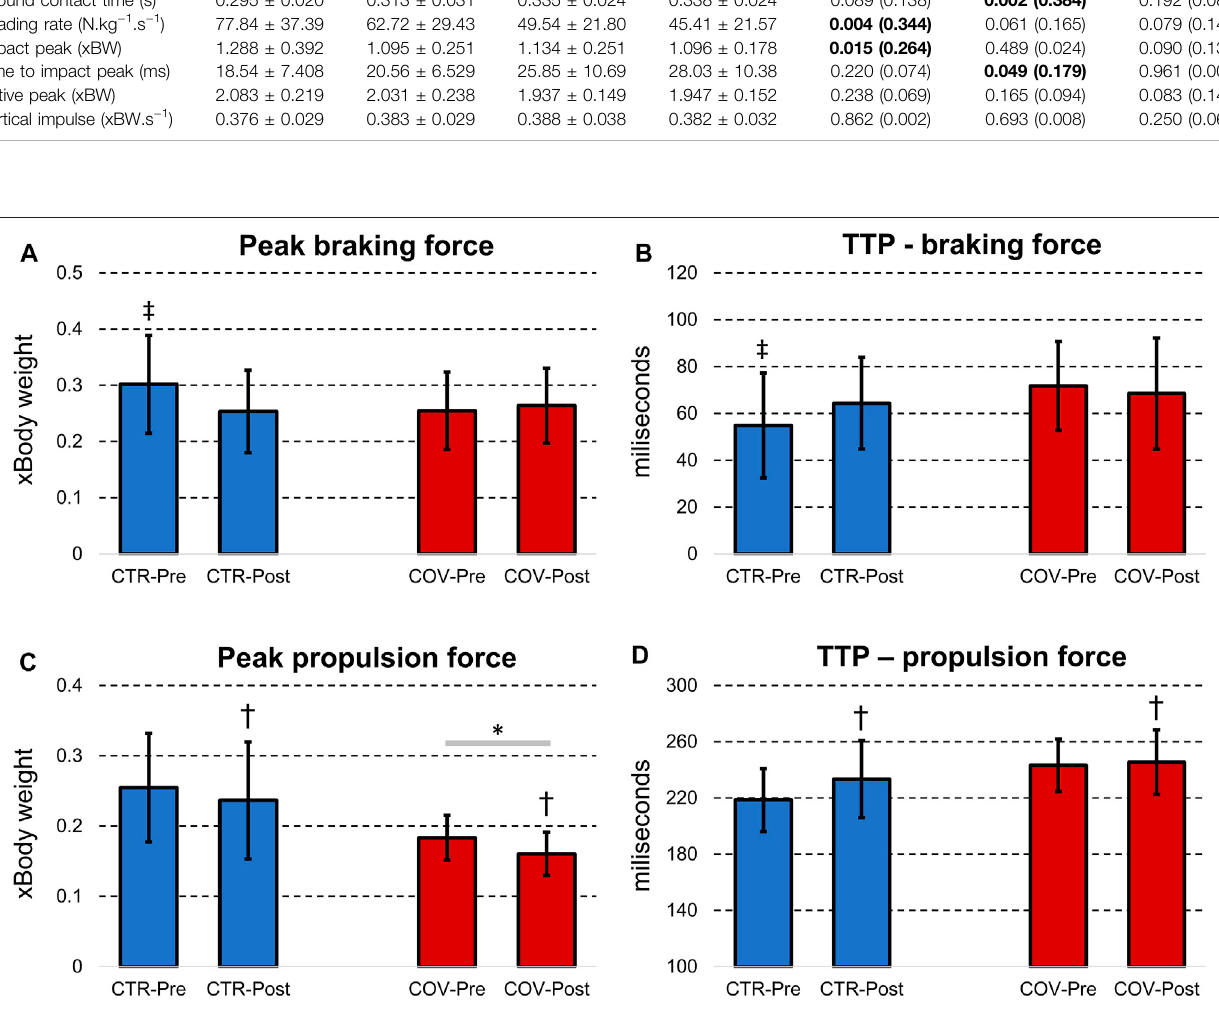
Frontiers in Physiology |